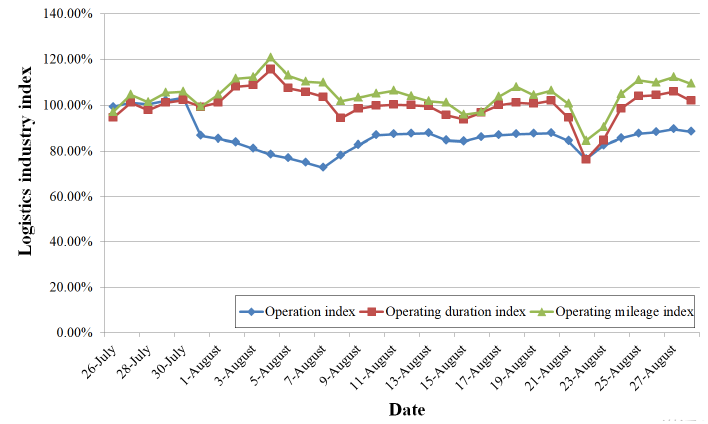
Figure 14. Logistics industry index during the pandemic.